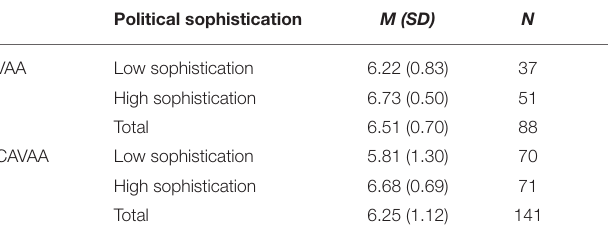
TABLE 4 | Means and Standard Deviations of the number of factual political knowledge questions answered correctly (Min. = 0; Max. = 6) in each